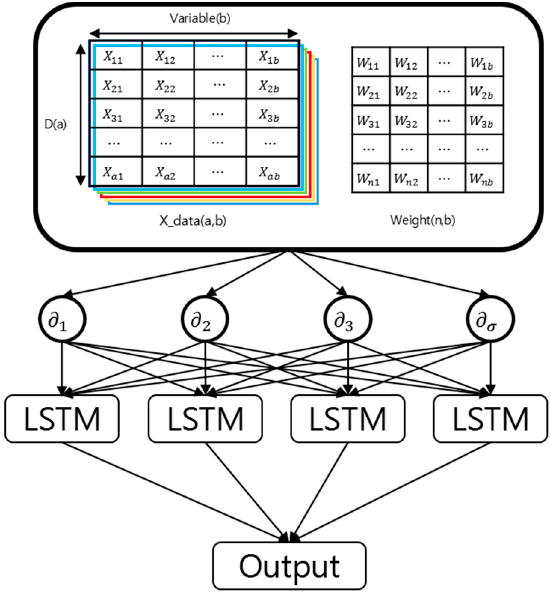
Figure 24. Structure of CNN + LSTM.